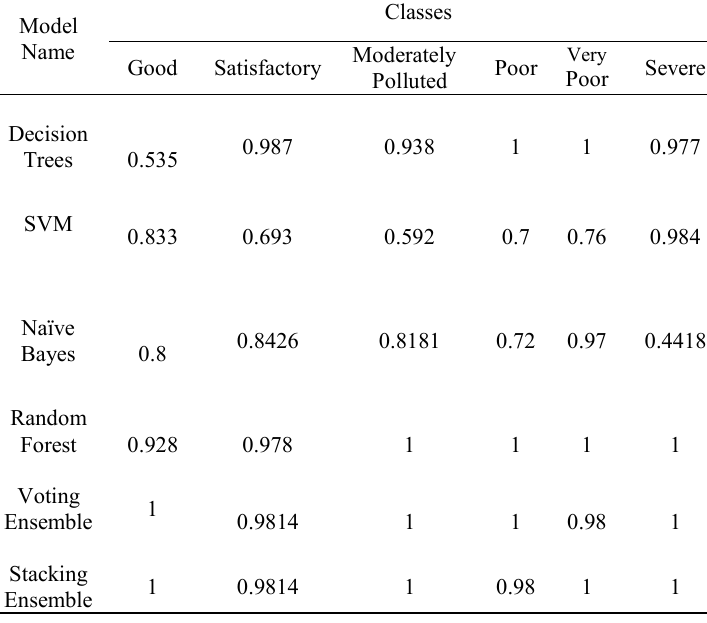
Table 4. Recall Values for Various Classification and Ensemble Techniques